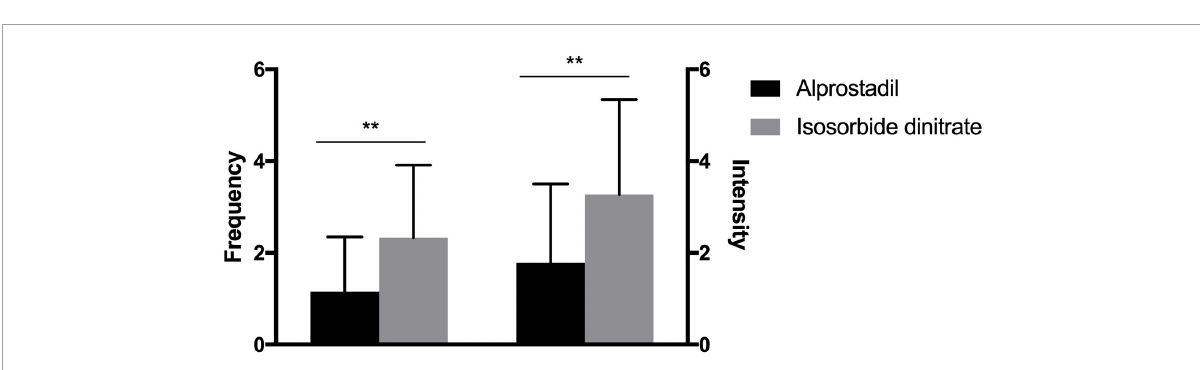
FIGURE3 Comparison of alprostadil vs. isosorbide dinitrate in the efficacy of alleviating angina frequency and intensity (medians and interquartile ranges). Statistical analysis was performed using the Mann-Whitney test. ** P < 0.01.